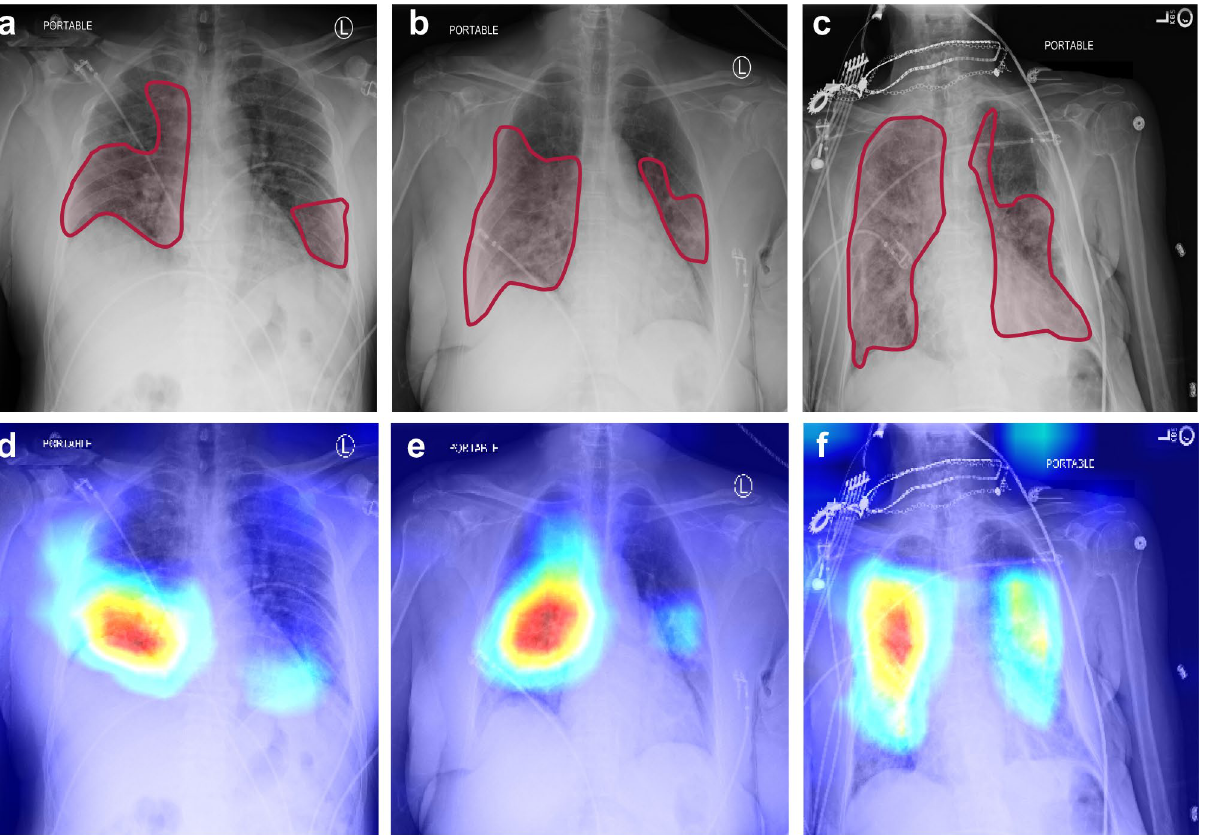
Figure 3. CXRs and saliency maps for three patients chosen from the unseen test dataset. The CXRs and affected areas for patients with ( a ) mild, ( b ) moderate, and ( c ) severe COVID-19 pneumonia (analyzed by our expert radiologist). ( d–f ) The corresponding saliency maps for CXRs (found by our AI approach). The true class probability for the images are 0.96, 0.67, 0.89, respectively. The saliency maps and regions of interest match well for all